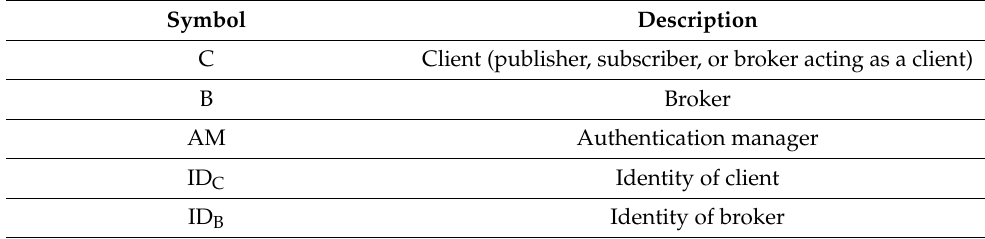
Table 3. Notation used in the authentication